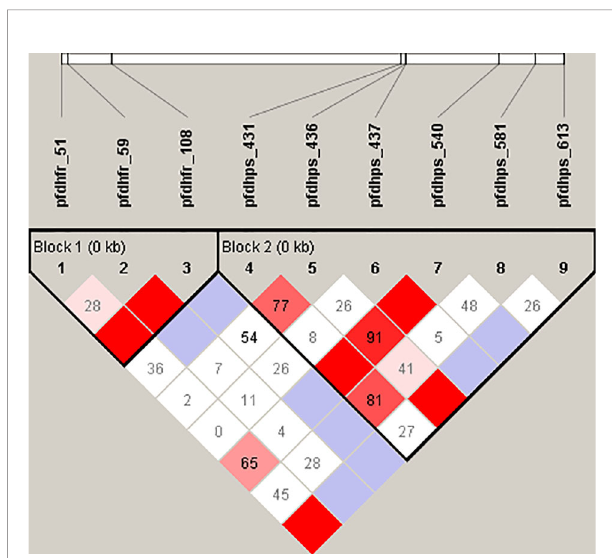
FIGURE 2 | Linkagedisequilibrium(LD)analysisof pfdhfr and pfdhps SNPs.For the pfdhfr gene,thesingleaminoacidmutationswereN51I, C59R, andS108N, respectively.Likewise, pfdhps genearerelatedtothemutationsS436A, A437G, K540E, andA613S, respectively. Thedarkandlightredsquaresindicatealinkage thatwasstatisticallysigni fi cant(P< 0.05).Cambridgebluesquaresindicate a linkagethatis present butis notstatisticallysigni fi cant(P >0.05).A whitesquare withindicatesthatno